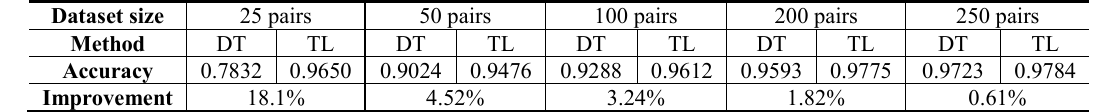
Table 5. The test accuracy on different size of training samples based on GC-net. DT means directly training on the dataset with random initial weights, while TL means transfer